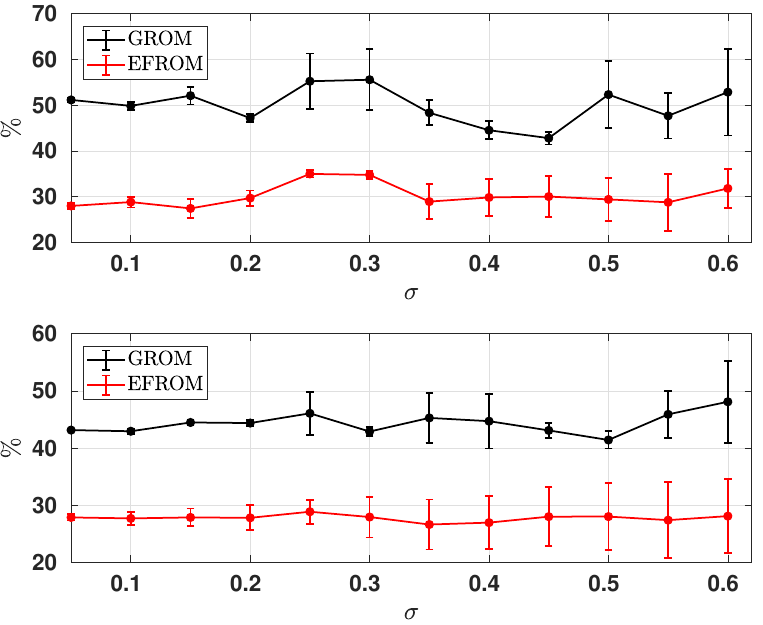
Figure 5. The ensemble averages of the relative L 2 error of G-ROM (dark line) and EF-ROM (red line) computed via Label (19) for dimension r = 6 ( top ) and r = 8 ( bottom ). The noise amplitude σ is equally spaced between 0 and 0.6. For each σ , 1000 simulations are carried out for SBE and ROMs. The error bars show the standard